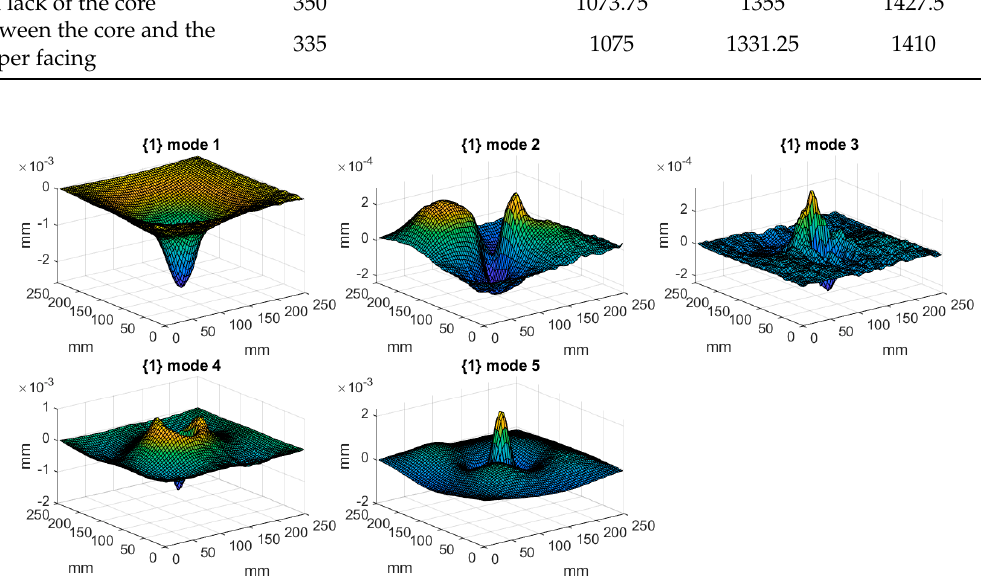
Figure 4. The considered mode shapes for the plate with a partial local lack of the core.